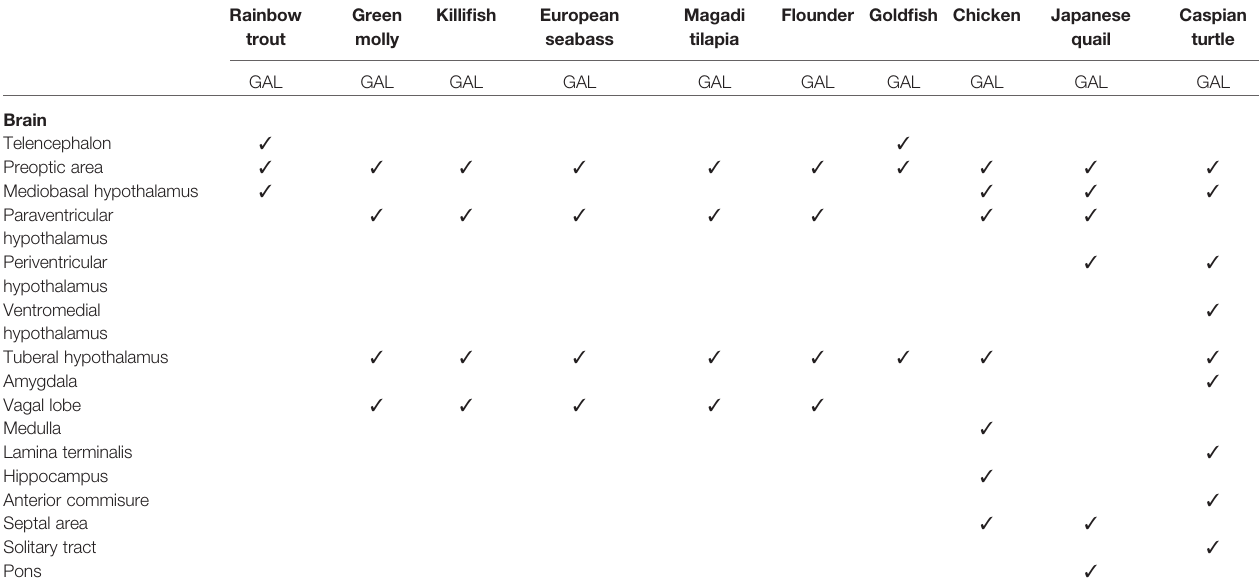
TABLE 1 | GAL-expressing cells were found in restricted brain regions of various non-mammalian species. However, GAL fi bers were widespread and extended all over the brain. Rainbow